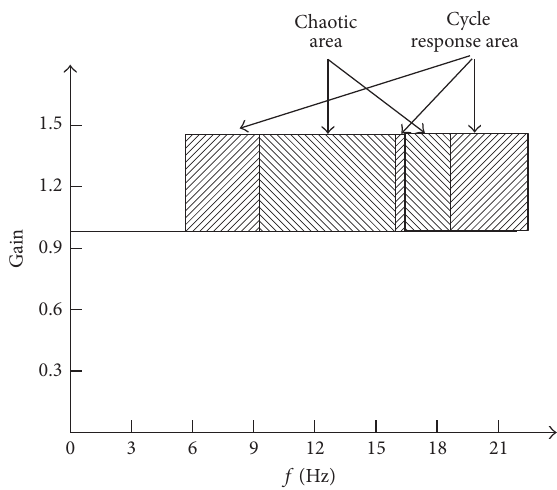
Figure 15: The parameters regime diagrams of system with different